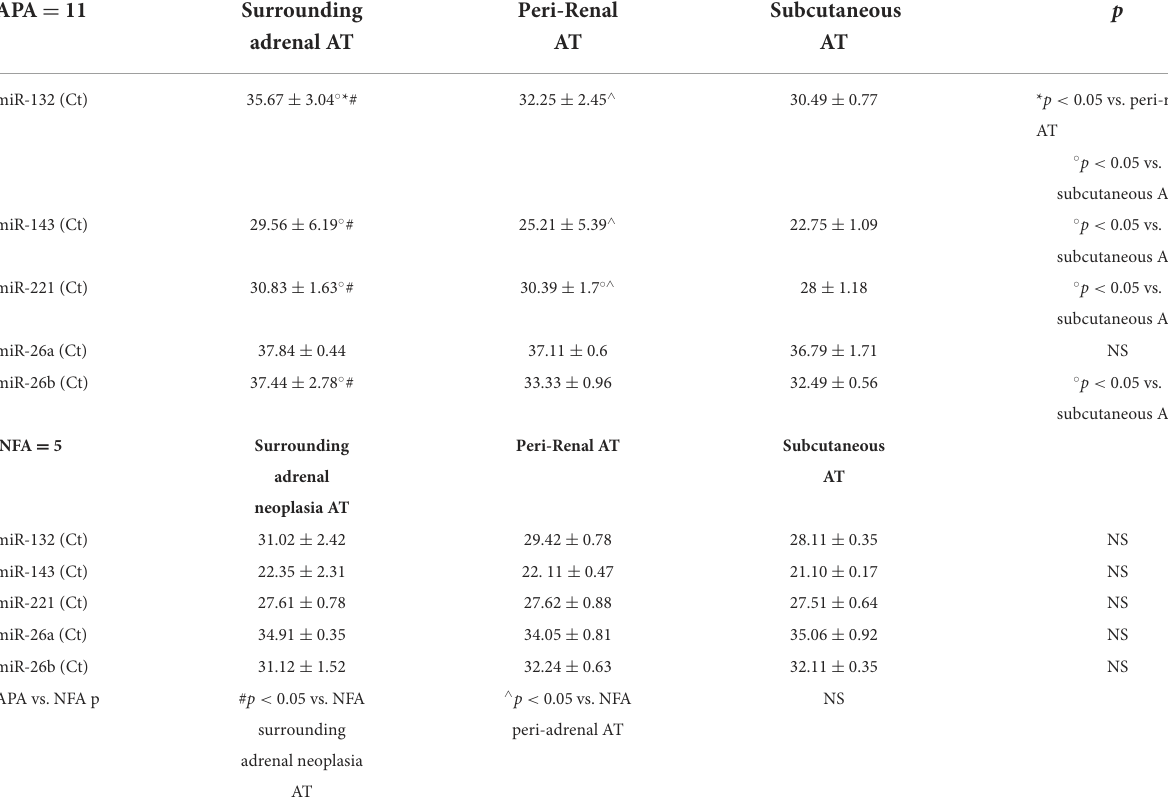
TABLE 5 Comparison between the real-time PCR cycle (Ct) averages for the different miRNAs analyzed, in the three types of AT of the patients with APA and NFA.